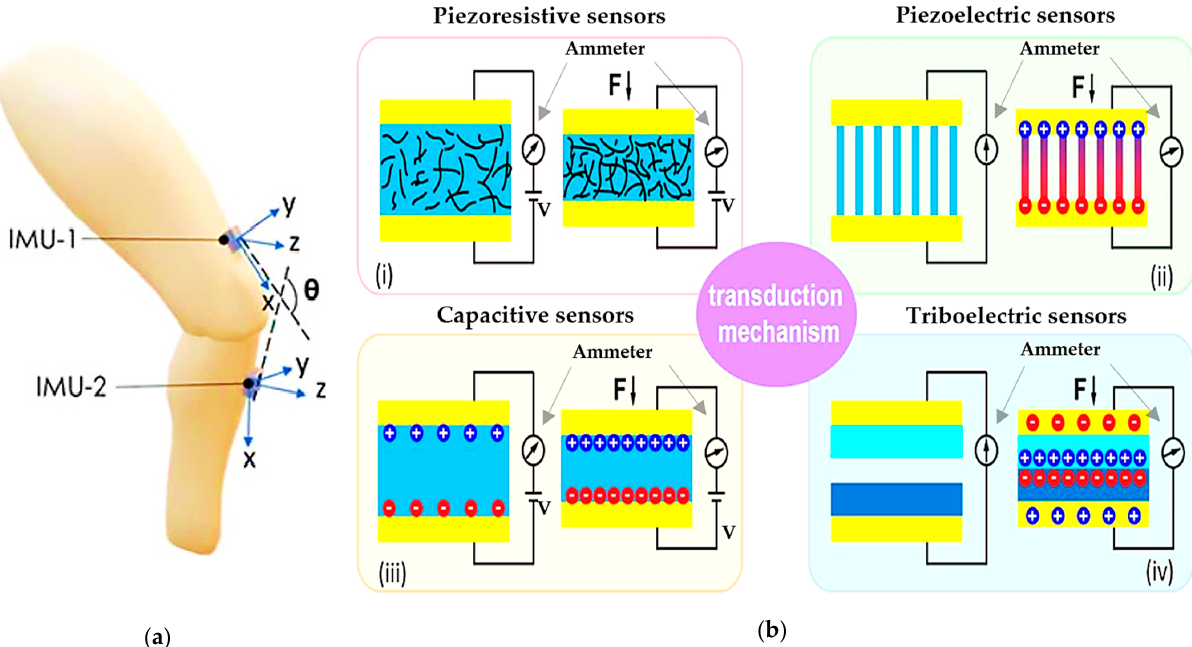
Figure 6. Schematic illustration of ( a ) inertial sensors (“reproduced with permission from S. Z. Homayounfar et al., SLAS Technology; published by Elsevier, 2020” [79]); ( b ) piezoresistive ( i ), piezoelectric ( ii ), capacitive ( iii ), and triboelectric ( iv ) sensors [80]). Electromechanical sensors based on different transduction methods, such as capacitive, triboelectric, piezoresistive, and piezoelectric effects, are more appropriate for wear- able applications. By virtue of the material used for their fabrication, these sensors are usually lighter, comfortable, robust, and suitable to detect physiological parameters di- rectly from the human body since they can be attached to or integrated into clothes, wraps,